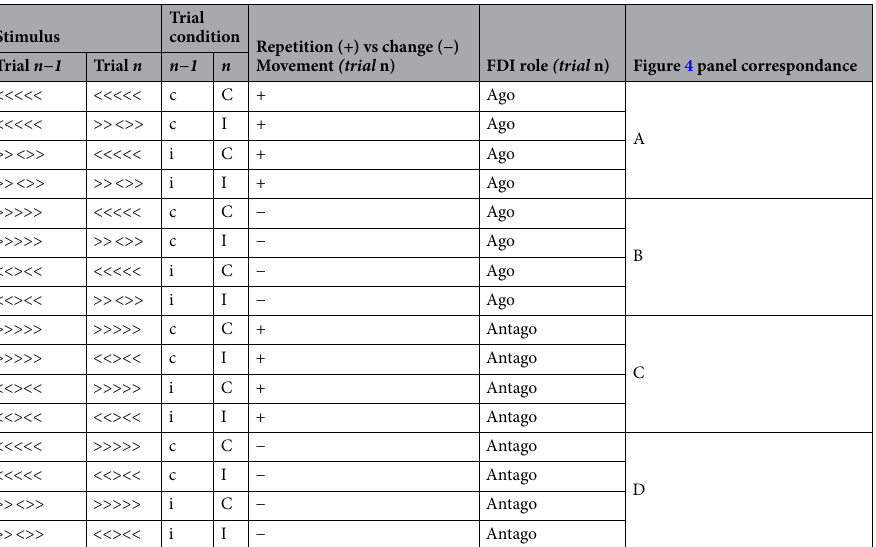
Table 1. The 16 different stimulus transitions employed in the flanker task. Letters at left refer to the congruent or incongruent condition of the previous (n−1; c or i) and the current (n; C or I) trial. Repetition or change in movement direction in transitions between trial pairs are indicated by (+) and (−), respectively. Also indicated is the agonist (Ago) or antagonist (Antago) role of the FDI muscle in the current (n) trial. The column at right indicates the trials used to calculate the CSE indexes presented in Fig. 4, with letters A,B,C,D corresponding to each figure